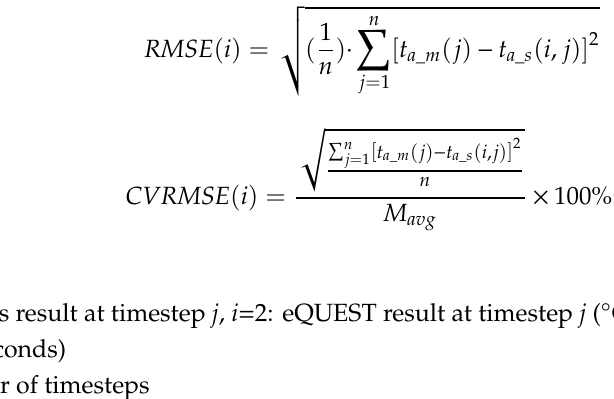
Figure 7. Simulated indoor air temperature compared to the measured data during occupied hours, referencing occupants count.